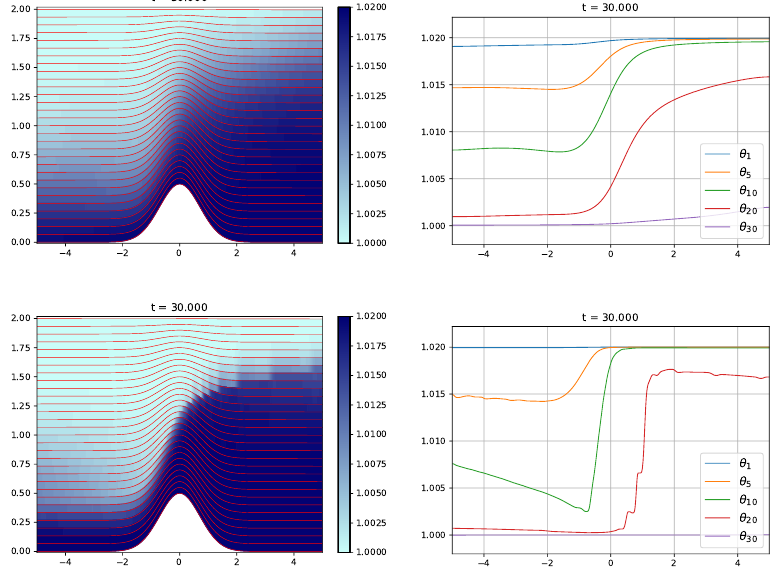
Figure 32. Distribution of the relative density θ . The first row corresponds to the first order scheme and the second row to the second order